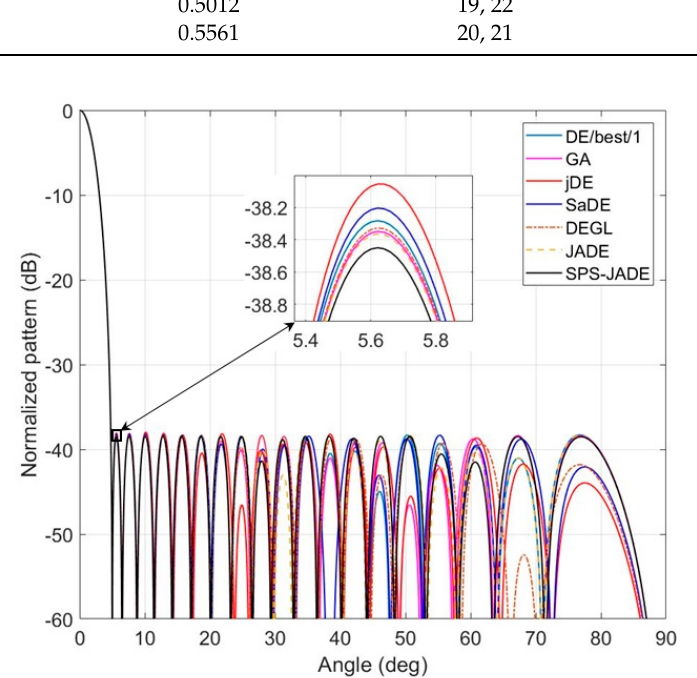
Sensors 2020 , 20 , x FOR PEER REVIEW Figure 3. The optimal patterns for the linear antenna array. Figure 3. The optimal patterns for the linear antenna array.